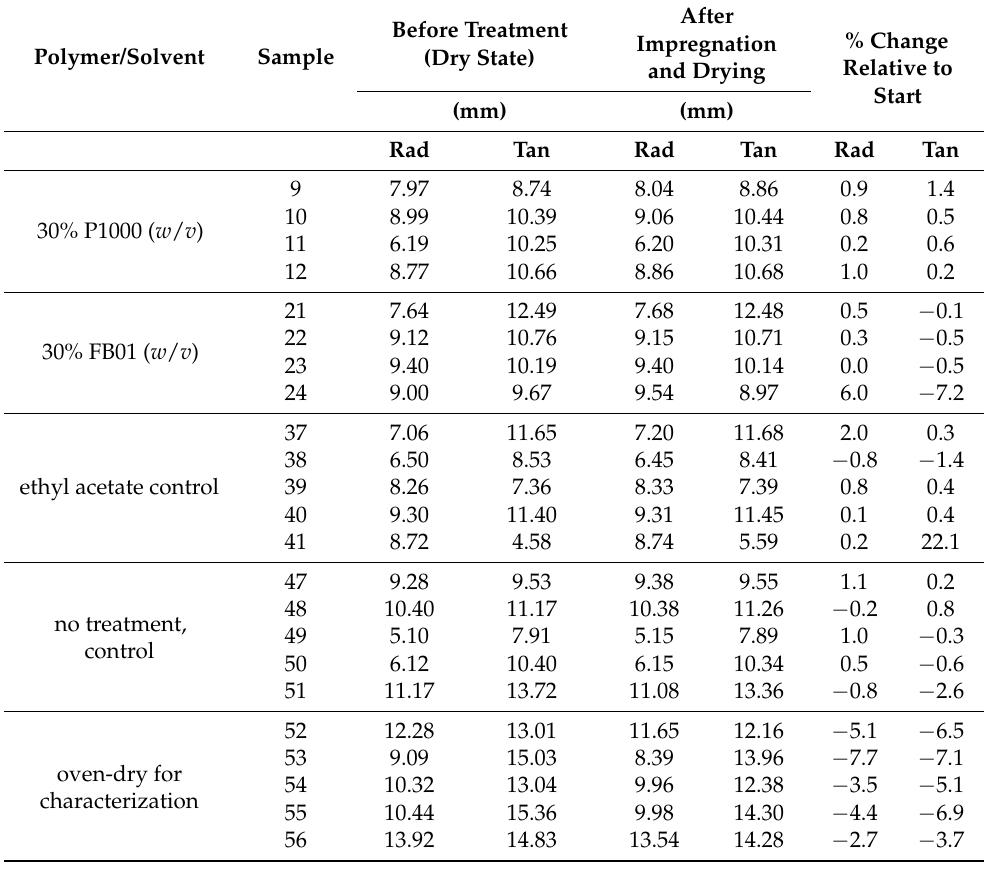
Table 7. Dimensional change in samples relative to before treatment. ‘Rad’ is the distance in the radial direction, and ‘Tan’ is the distance in the tangential direction on the transverse face.